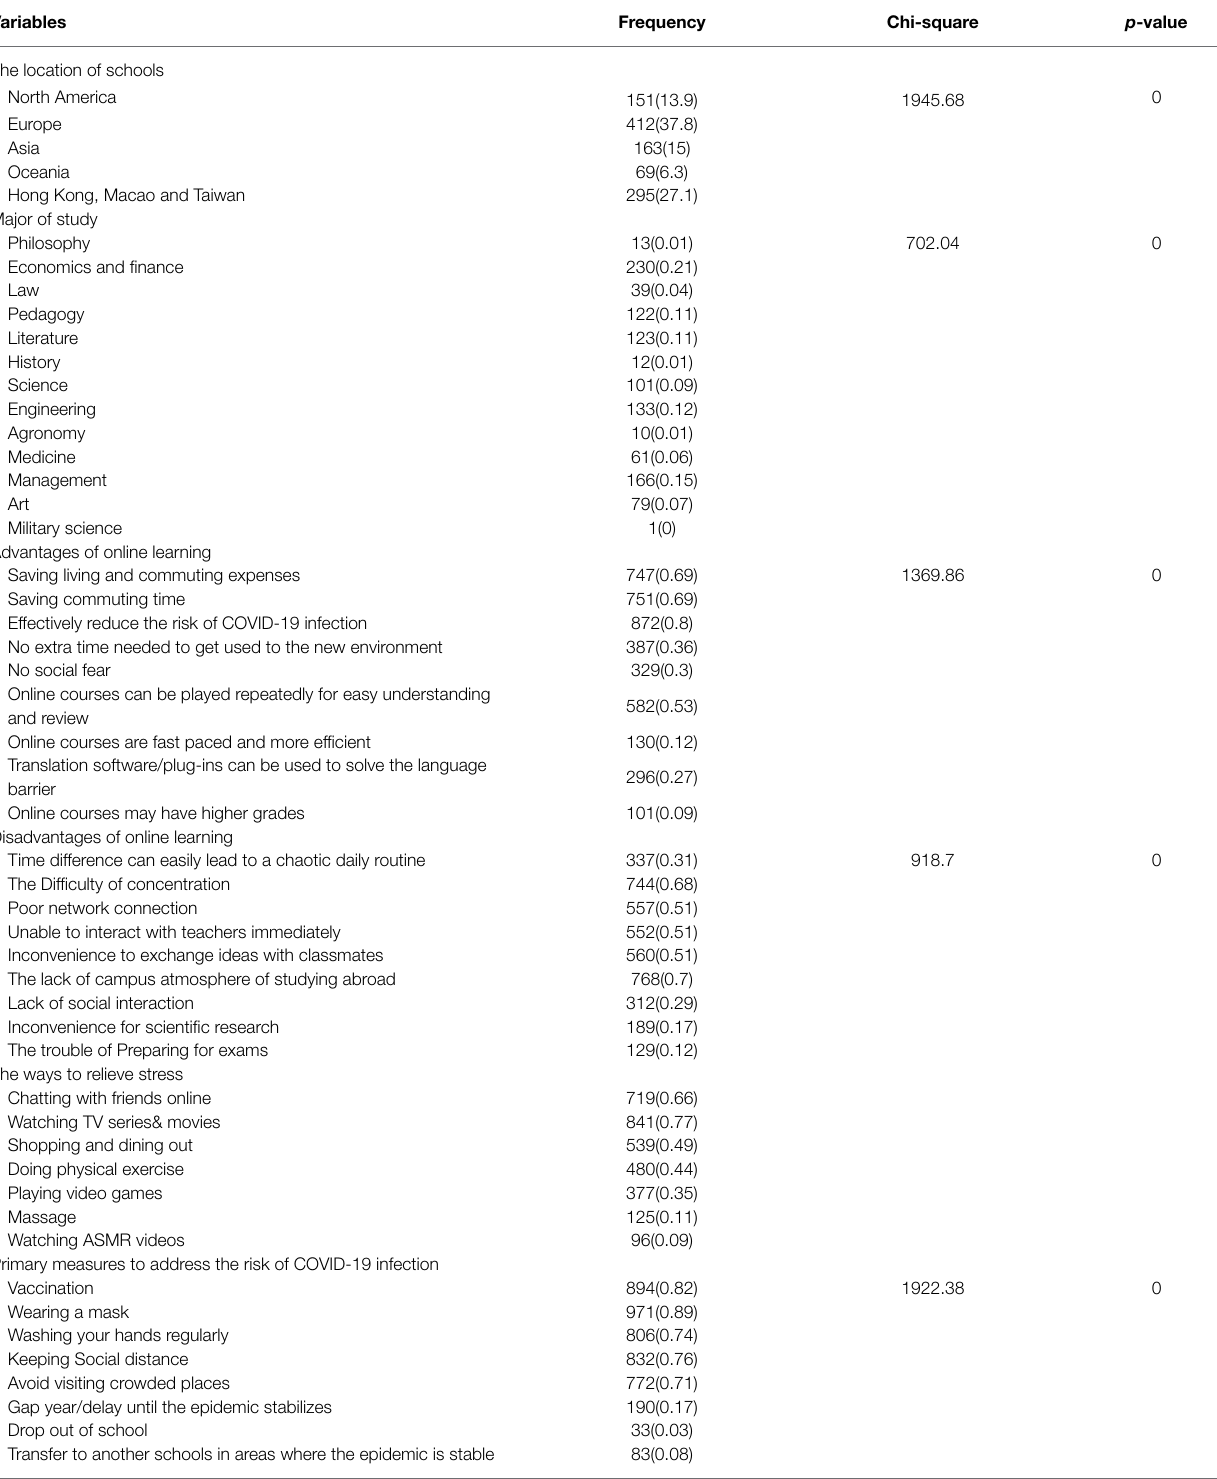
TABLE 1 | General situation of 1,090 Chinese international students who studied online during the COVID-19